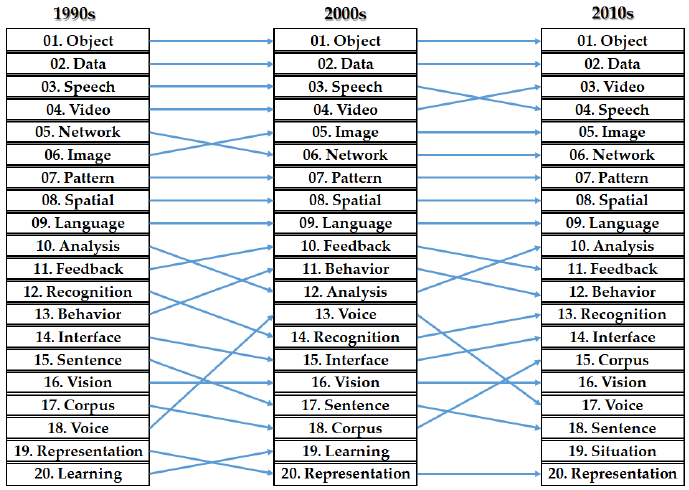
Figure 2. Technological changes of top 20 AI keywords over time. Table 7. Width ranking of Bayesian prediction intervals: all AI keywords.